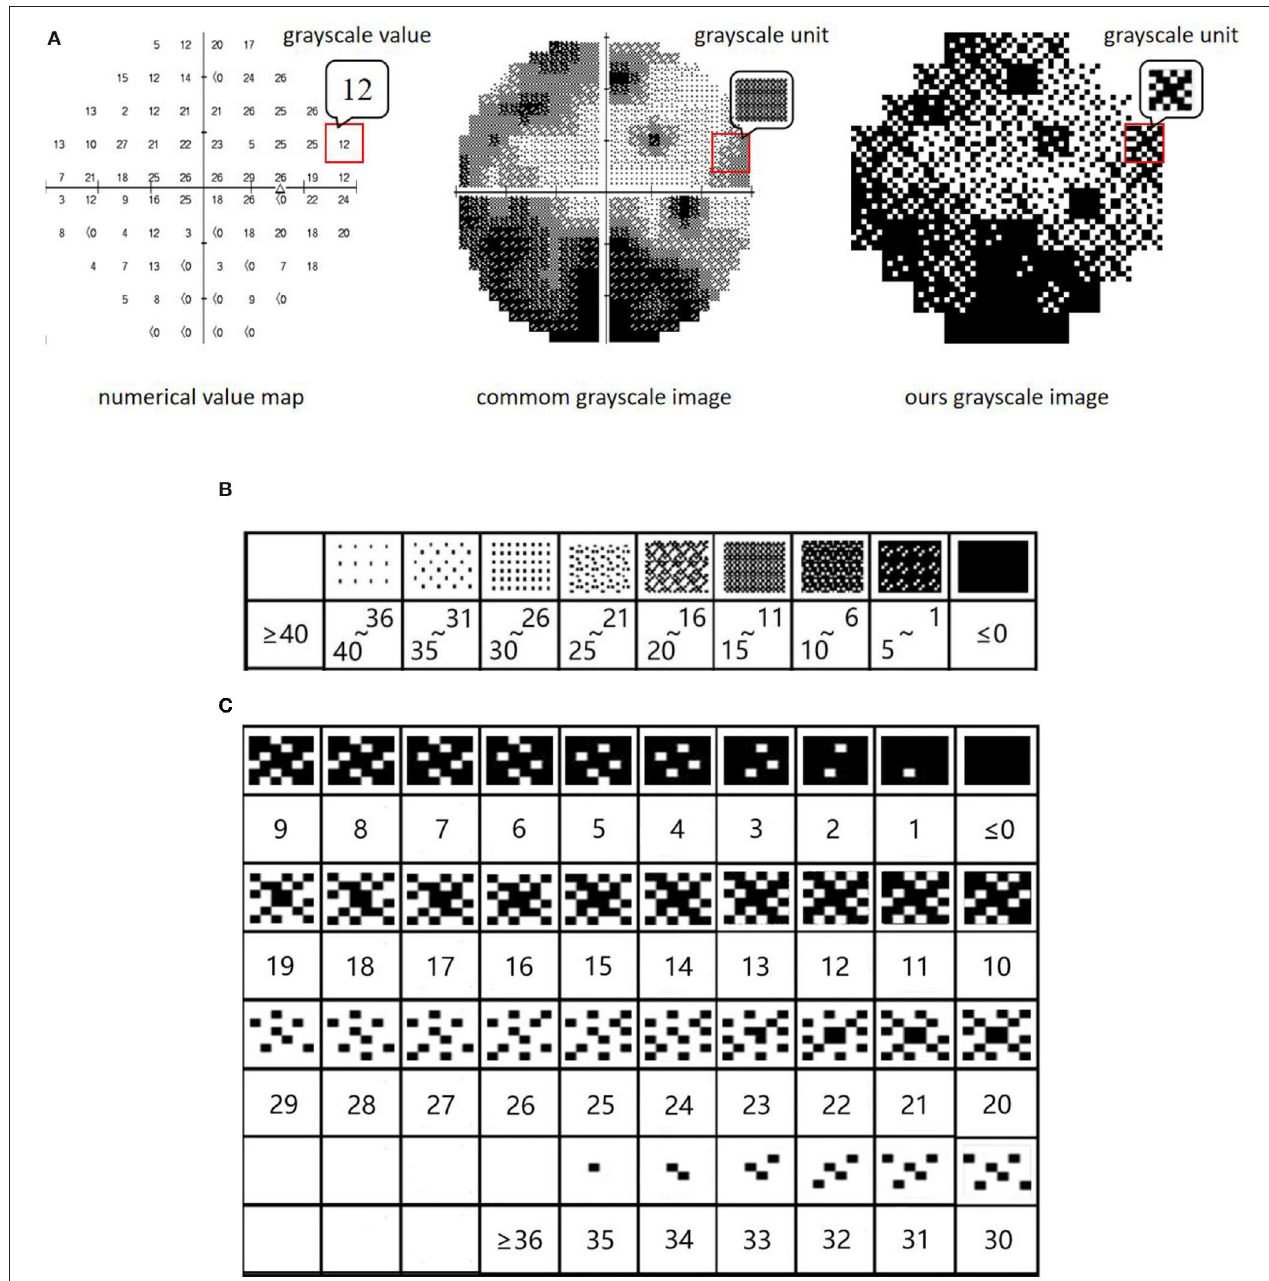
FIGURE 3 | (A) Gray scale images of visual field. (B) Ordinary gray scale units. (C) New gray scale